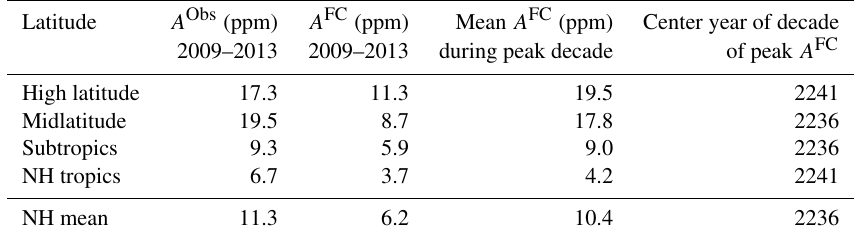
Table 4. Observed and FullyCoupled 2009–2013 mean CO 2 annual cycle amplitudes and corresponding decades when peak FullyCoupled amplitudes occurred in each latitude band shown in Fig.